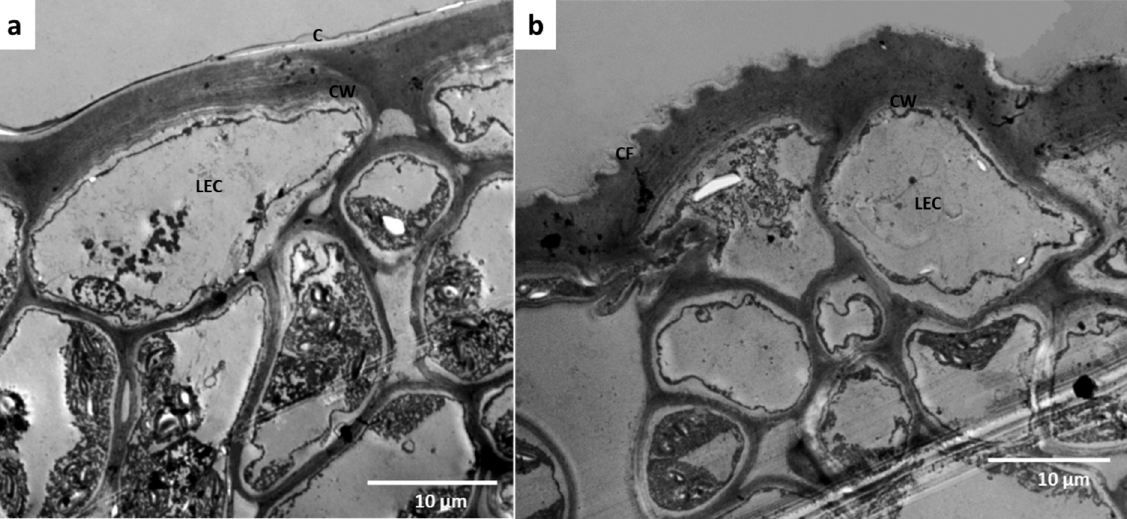
Figure 7. The anatomical modification of the epidermis in the domatia of Gardenia thunbergia ; ( a ) non-domatial epidermis, ( b ) cuticular fold in domatial epidermal layer. C: cuticle, CF: cuticular fold, CW: cell wall, and LEC: lower epidermal cell.